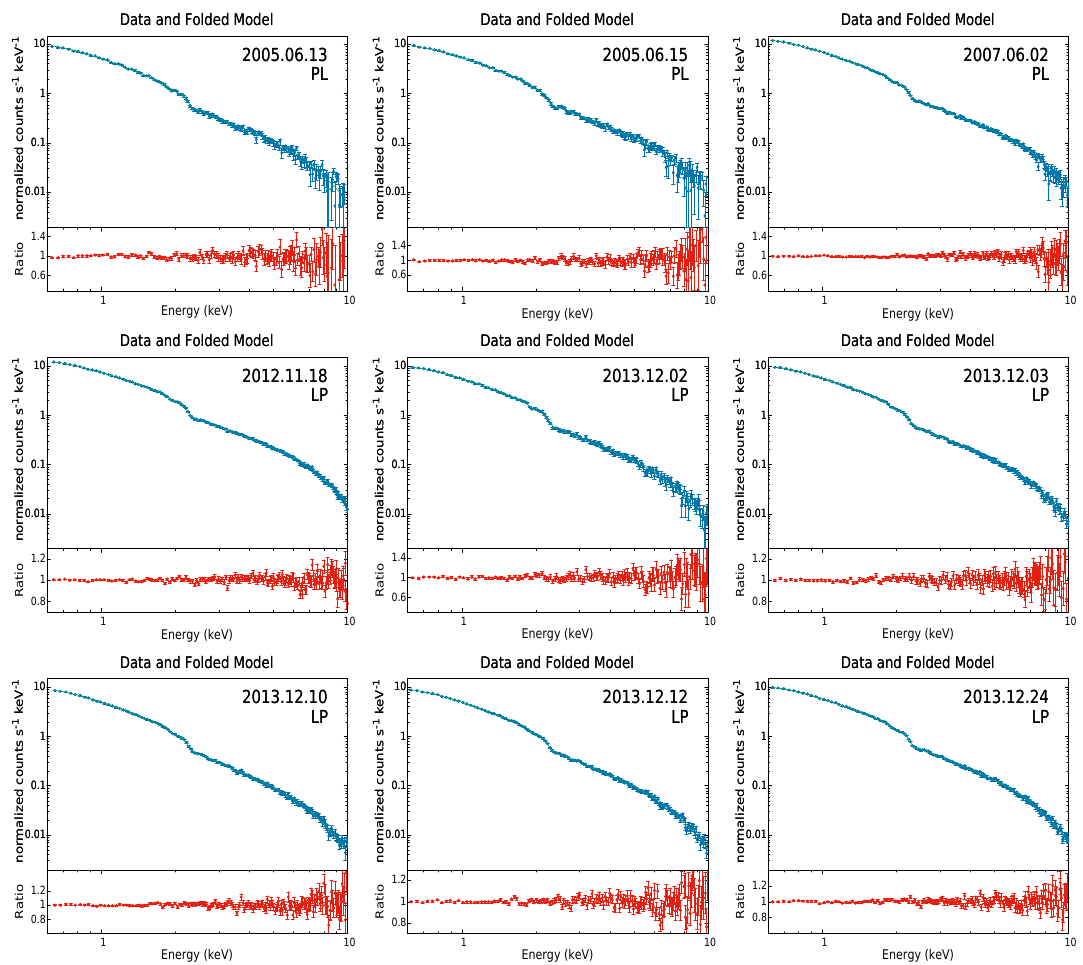
Figure 3. The spectra and ratio (data/model) of best fitted model for XMM-Newton observations of H